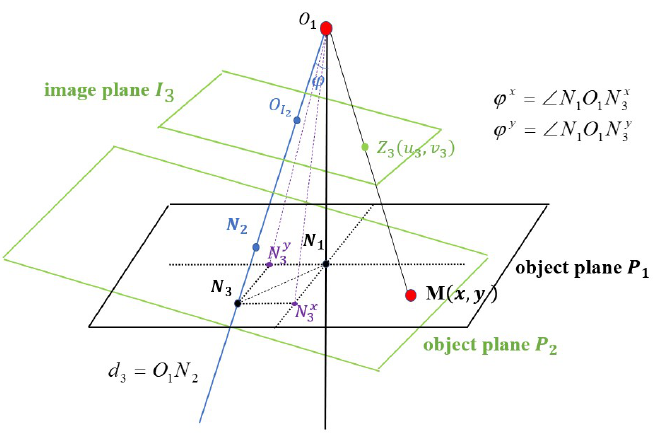
Figure 7. The spatial relationships before and after the optical axis rotation with angle ϕ = ( ϕ x , ϕ y ) .